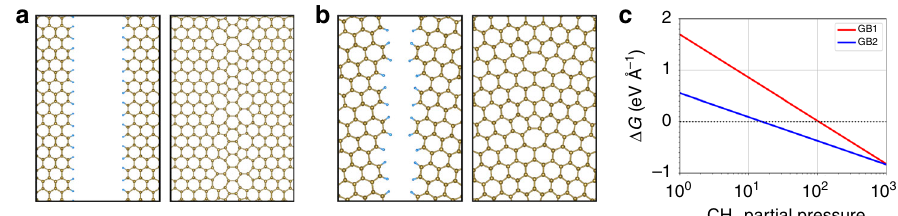
Fig. 4 DFT simulation of graphene grain boundary energetics with methane partial pressure. a , b represent two random mis-orientations GB1 and GB2, respectively. For both, the grain edge passivated with hydrogen, blue atoms, and defect structure on boundary formation are shown. c The free energy change, Δ G , for these two con fi gurations as per equation (3) vs methane partial pressure. A crossover in the plot suggests that depending on the methane partial pressure the reaction can proceed in the forward or backward direction. Increase in pressure favors boundary formation and vice-versa as observed experimentally. The pressure at which it happens depends on the boundary misorientation